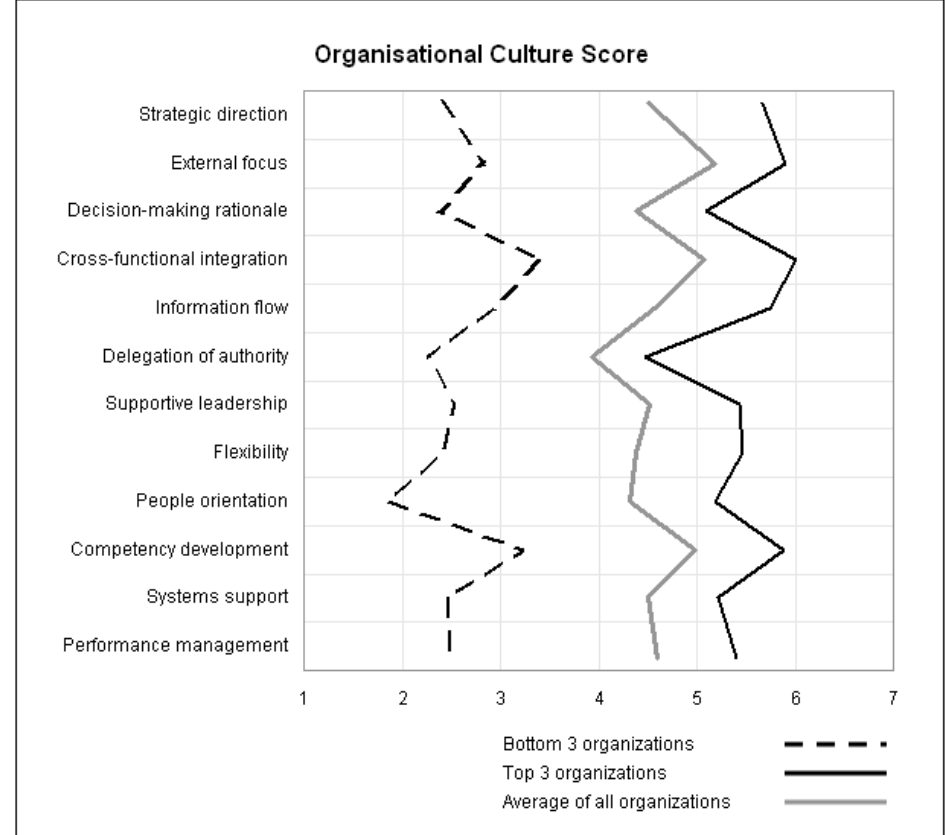
Figure 2: Scores on the organizational culture